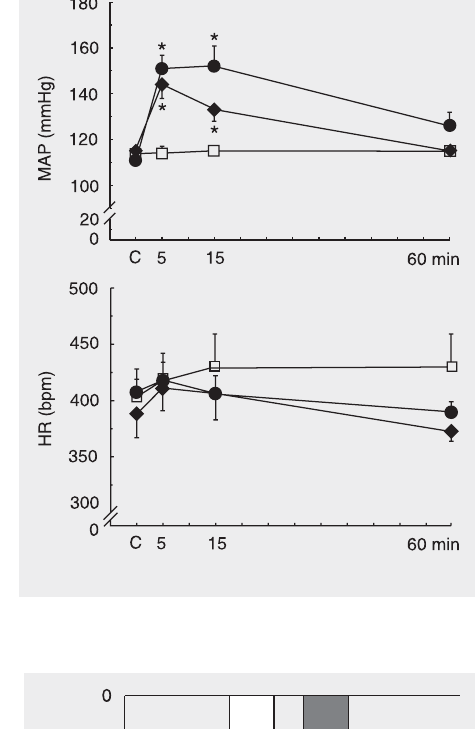
Figure 4. Changes in mean ar- terial pressure ( ∆ MAP, top) and heart rate ( ∆ HR, bottom) pro- duced by iv injections of 5-HT (2 µg/rat) before (control response, open bars) and 10 min after cho- linergic blockade with iv injec- tions of atropine methyl bromide (1 mg/kg, N = 8; filled bars). Data are reported as means ± SEM. *P < 0.05 compared to the respective control (paired t -